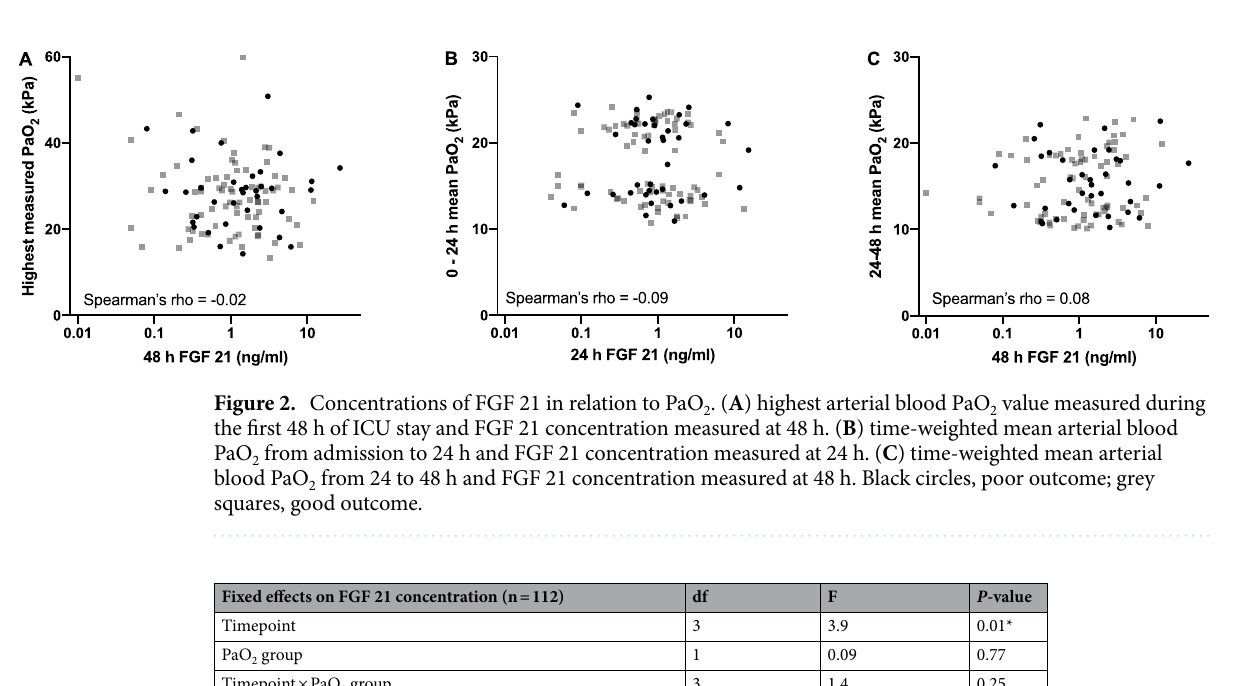
Figure 1. Concentrations of FGF 21 in controls (N = 40) and outcome groups of study patients. Median with interquartile range (box) and 10–90th percentile (whiskers) are presented. Note the logarithmic scale. Good outcome (N = 73), 6-month Cerebral Performance Categories (CPC) 1–2; Poor outcome (N = 39), 6-month CPC 3–5. *Difference between the outcome groups is statistically significant at the P < 0.05 level (Mann Whitney U test not adjusted for multiple comparisons).